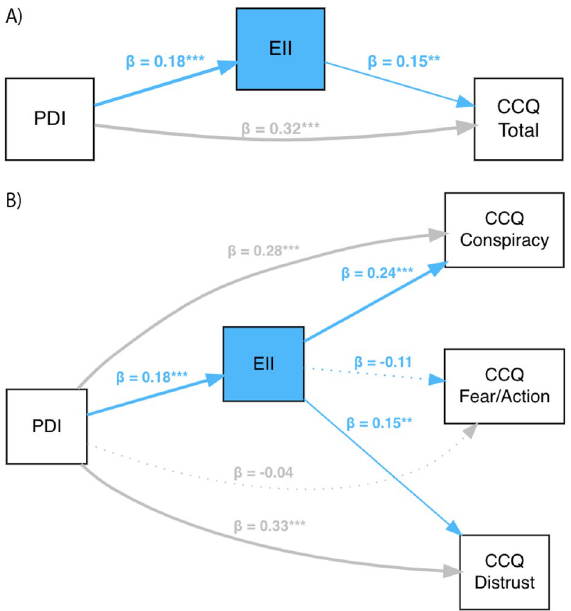
Figure 3. Results of path analyses with standardized parameter values. ( A ) Shows the CCQ Total path-model. ( B )Shows the CCQ Components path-model; ** p < 0.01, *** p <